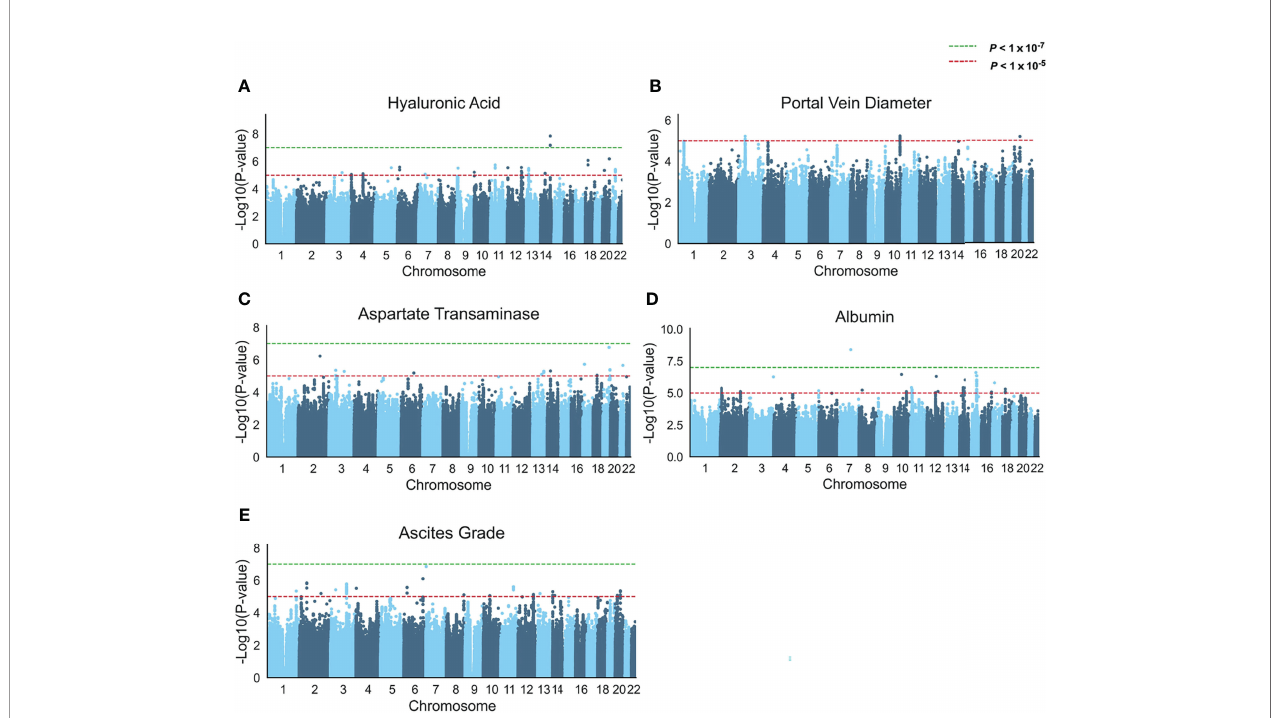
FIGURE 1 | Genome-wide association analysis of fi ve schistosomiasis-related indicators. (A – E) Manhattan plots of the association statistics from fi ve GWAS analyses (controlled for potential population strati fi cation, n=637) (A) Serum levels of hyaluronic acid (B) Portal vein diameter (abnormal n= 177 and normal n=460) in a logistic regression model, (C) Serum levels of aspartate transaminase, (D) Serum levels of albumin, and (E) Ascites grade. The y axis shows the negative log10-transformed SNP two-sided P value from a linear or logistic regression model, and the x-axis is the base-pair position of the SNPs on each chromosome. The green dashed line indicates the genome-wide signi fi cant P value ( P <1×10 -7 ) cutoff by Bonferroni correction, the red dashed line indicates a suggestive threshold ( P <1× 10 -5